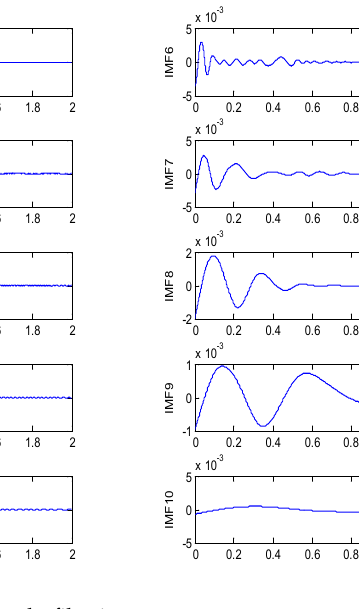
Figure 5. IMFs obtained by IEMD and the corresponding FFT frequency − spectrum.